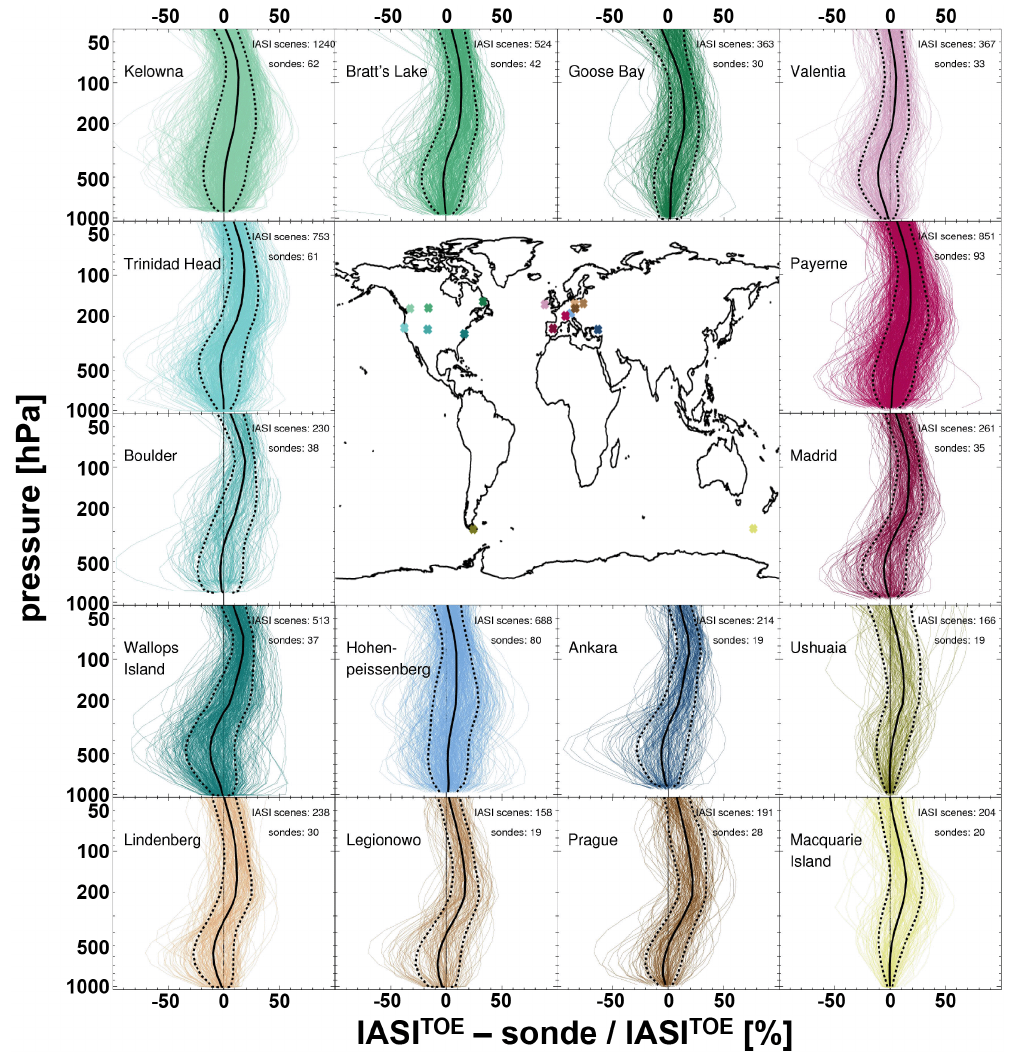
Figure 5. Bias of the IASI-TOE profiles with respect to ozone sonde profiles separated by location. The numbers of profiles included are indicated in the legend. The averaging kernels and ozone a priori profiles have been applied to the ozone sonde profiles. The coloured lines show the individual biases, the black solid lines the means, and the dashed lines the 1 σ standard deviations of the averaging. No significant differences in the individual biases or standard deviations can be observed for the different